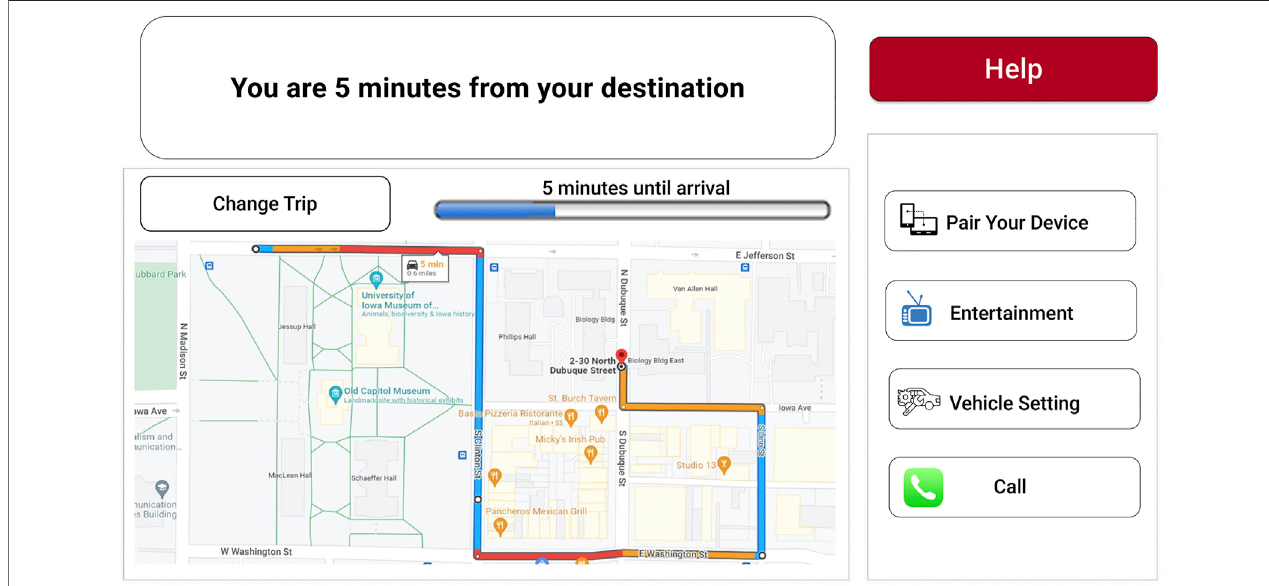
FIGURE 10 | Prototype of the arrival preparation